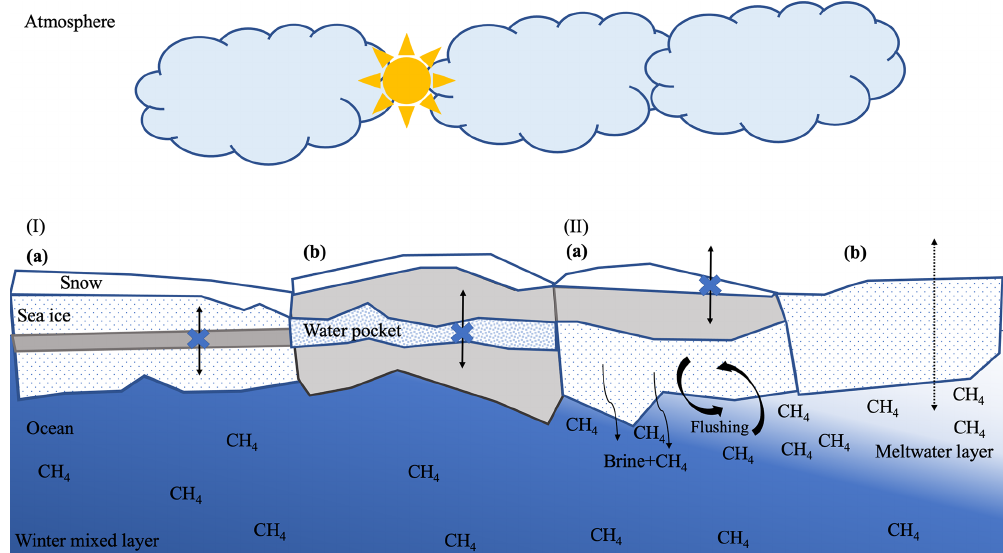
Figure 5. Potential pathways of methane in sea ice with varying impermeable (indicated in grey) and permeable sections (in white with blue dots), i.e., winter (I) and spring (II) conditions. I (a) Relicts of the initial methane signal (source) entrapped in impermeable ice layers. Impermeable intermediate sea ice layers act as a barrier for the upward/downward transport of methane (black arrow overlaid by a blue cross). (b) Residual methane signal after methane oxidation occurred in permeable sea ice layers (“water pocket”), enclosed by impermeable ice layers (see Fig. 6). II (a) When basal melt starts, but the top layer still is impermeable and with snow cover (white layer on top of the ice), downward brine transport initiates release of dissolved methane. Flushing events trigger methane released into the ocean (see Sect. 4.1.3). (b) Unrestricted migration of methane in permeable sea ice layers (dotted black arrow). Ongoing sea ice melt, when freshwater from melted sea ice is released into the water underneath, resulting in a meltwater layer where methane remains sustained during late spring. Methane (CH 4 ) annotation indicates concentration. Color gradient in the ocean reflects the increasing stratification during the seasonal evolution of the upper part of the winter mixed layer (in blue) into a fresh meltwater layer (in